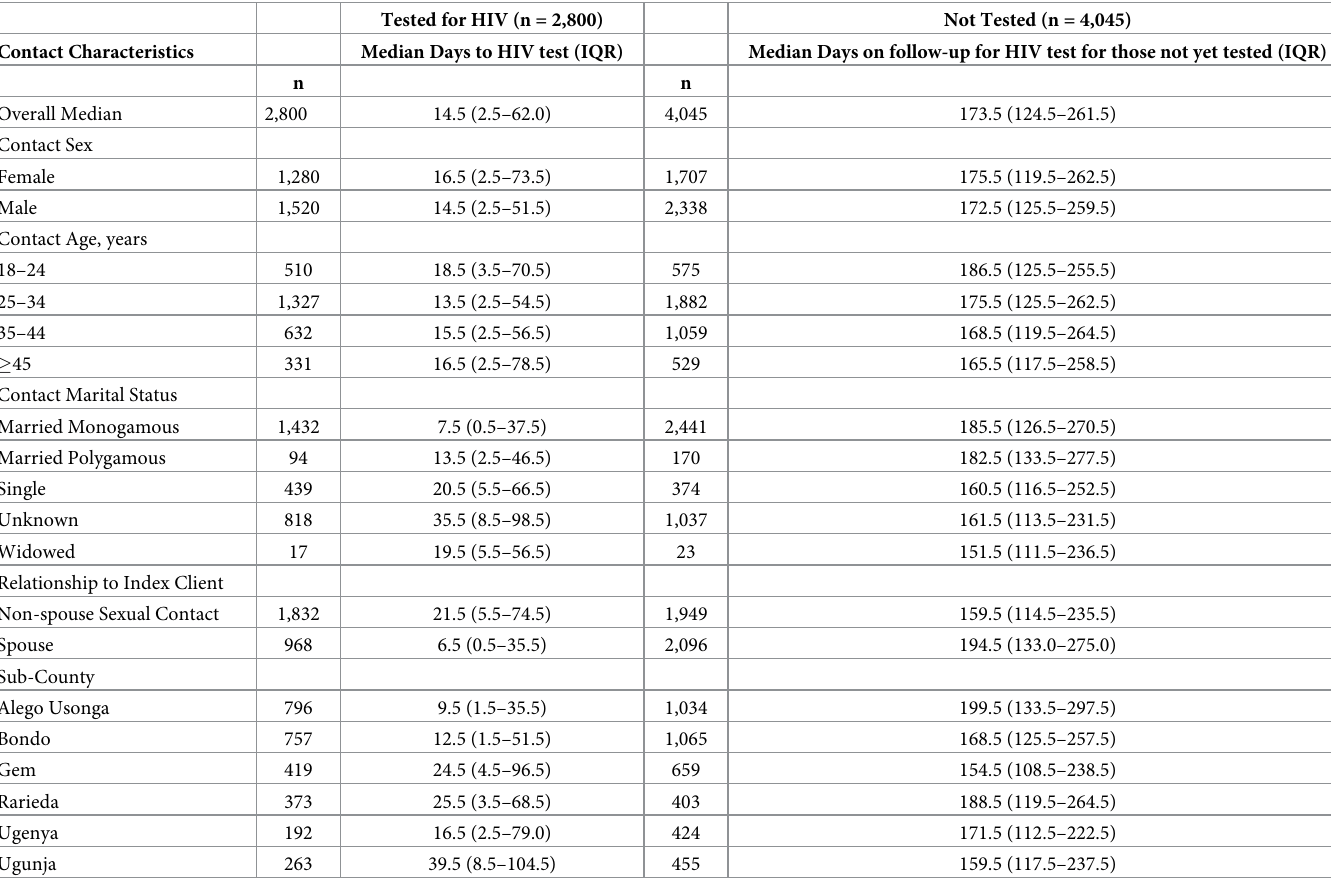
Table 2. Time to HIV testing and follow-up among identified sexual contacts of HIV-positive index clients in Siaya County, Kenya. Tested for HIV (n = 2,800) Not Tested (n =